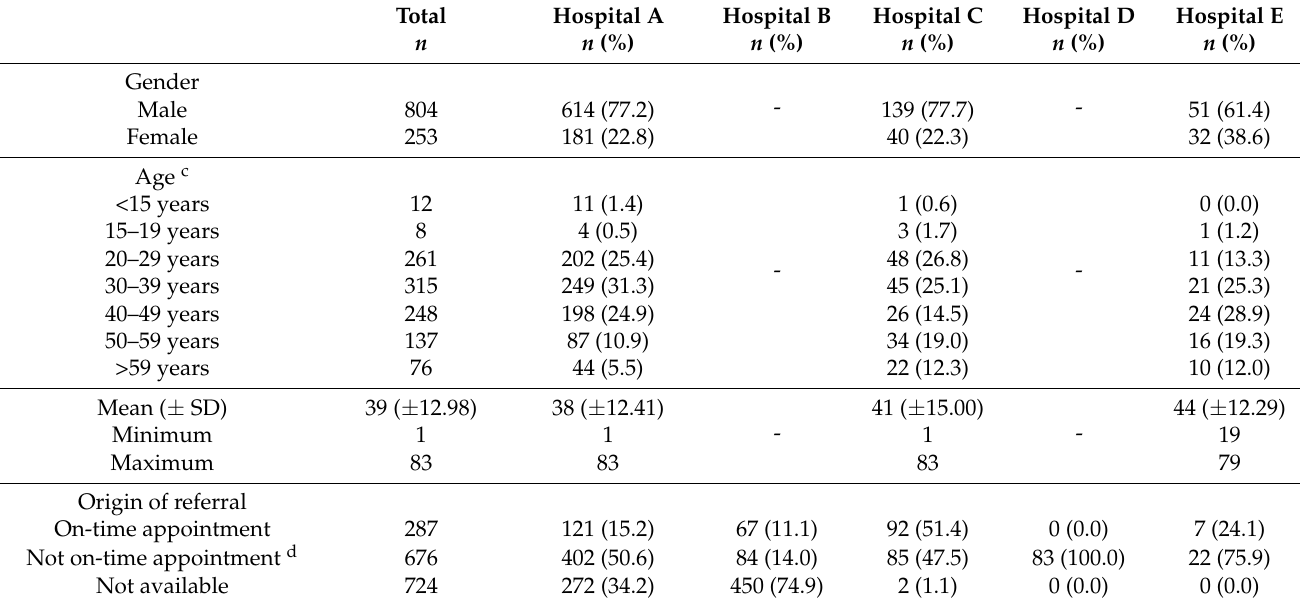
Table 2. Demographic characteristics of patients on ART a , by referral hospital b , in